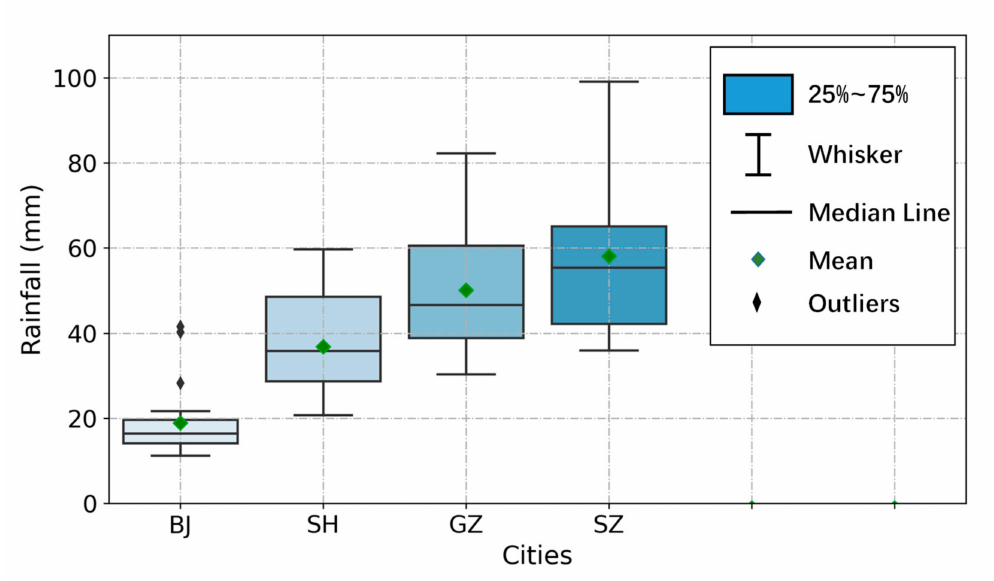
Figure 4. A box and whisker plot of Rx3h magnitude in study cities (The whisker range within 1.5IQR,